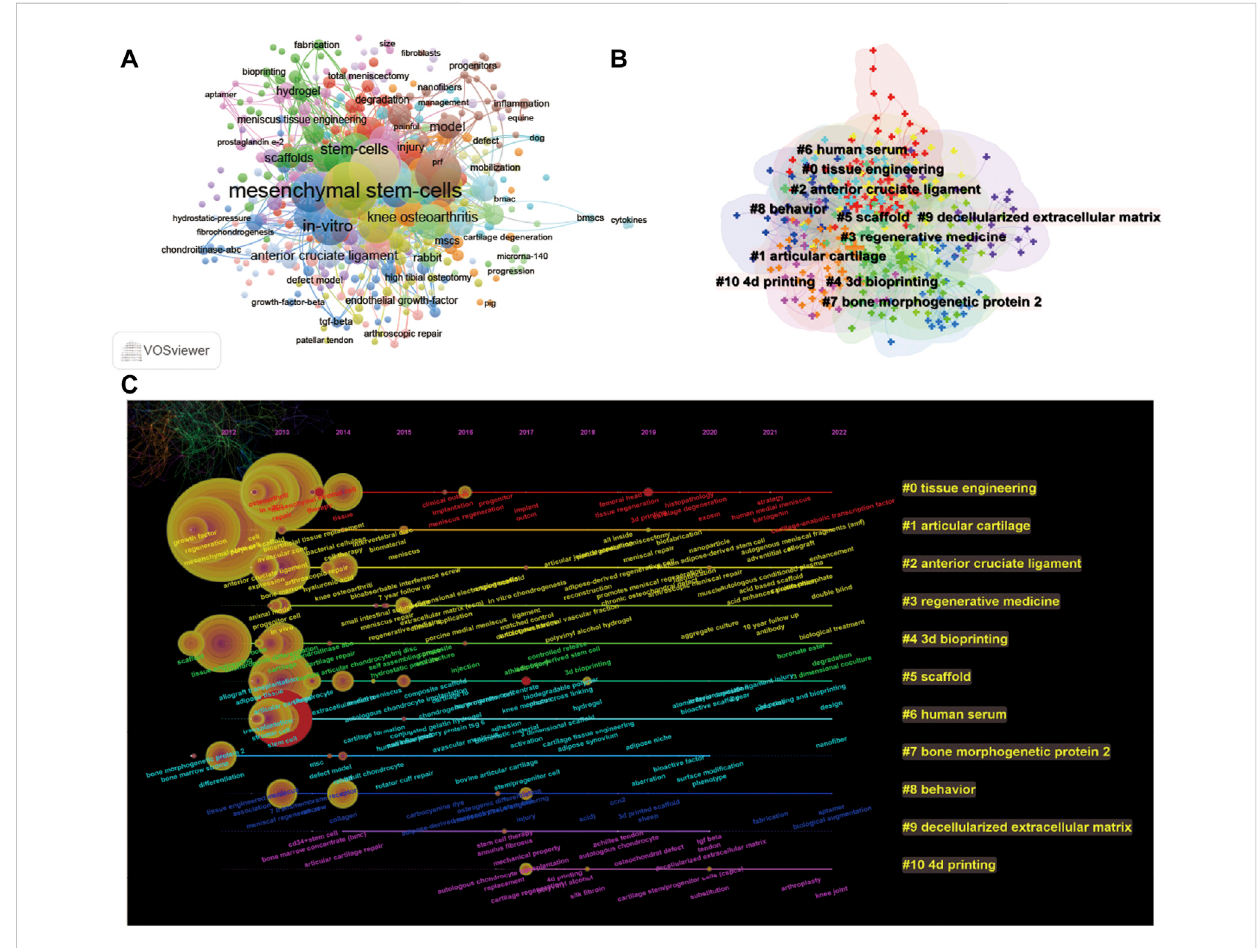
FIGURE 11 Mapping of keywords in studies on stem cells for meniscal regeneration. (A) Network visualization of keywords based on Vosviewer. (B) Keyword clustering visualization from 2012 to 2022. (C) Keyword timeline visualization from 2012 to 2022.